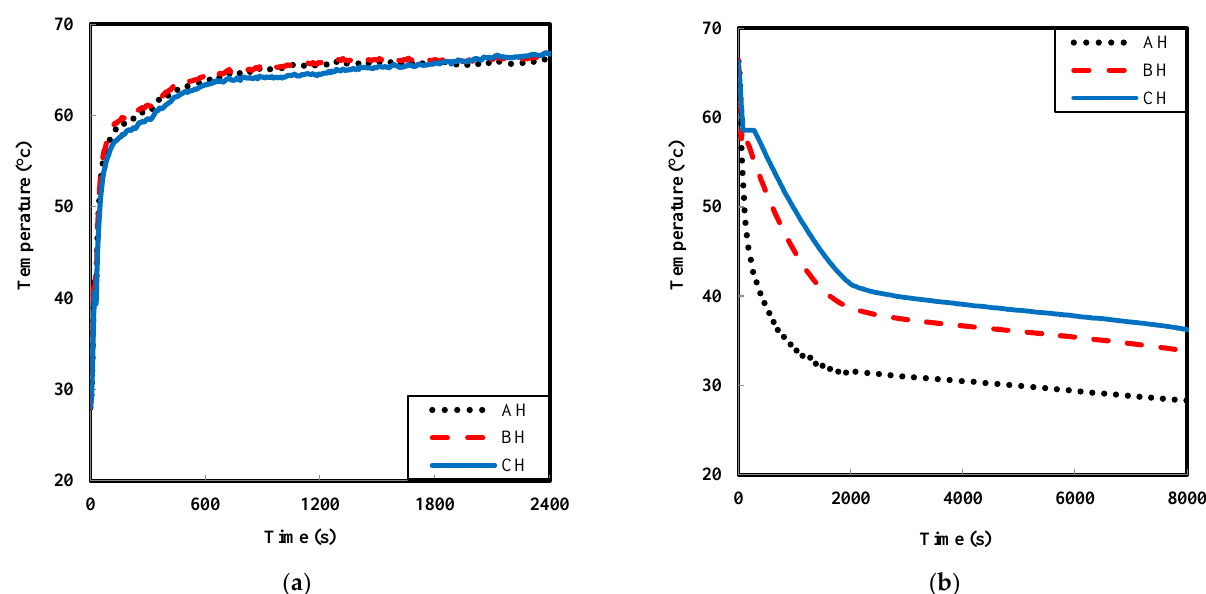
Figure 4 . The temperature of the heat pipe in different heights during the ( a ) charging and ( b ) discharging processes.